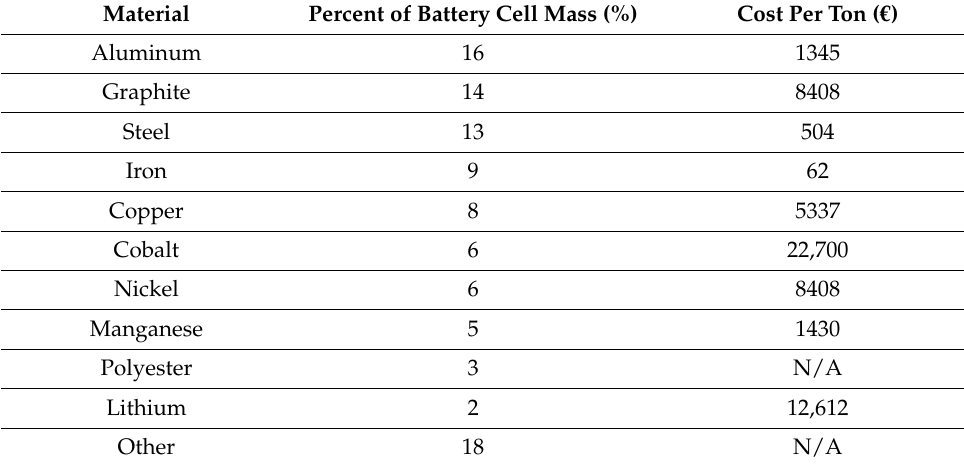
Table 1. Representation of materials in the battery and its prices of Chevrolet Bolt EV